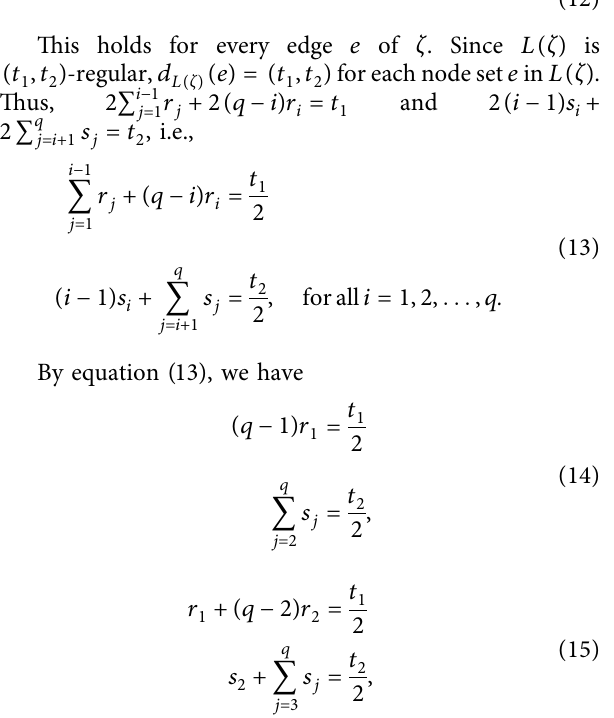
Figure 5: ζ is a ( d or